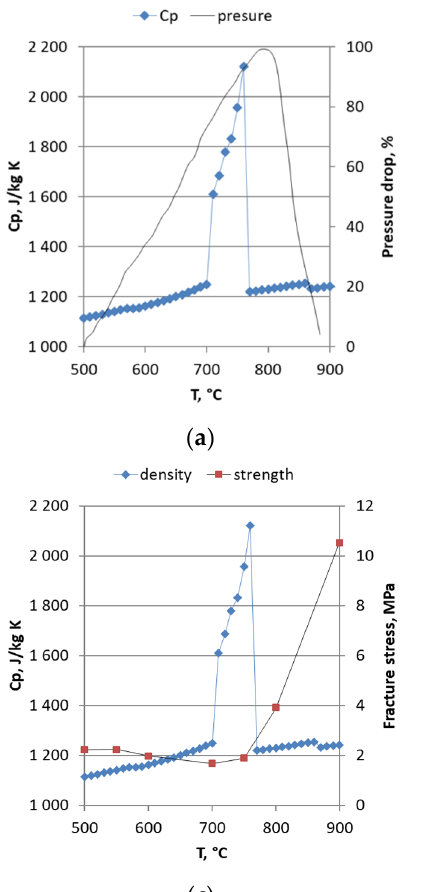
Figure 8. Barley straw: ( a ) Specific heat (c p ) and pressure drop as a function of temperature; ( b ) density (  )and pressure drop as a function of temperature; ( c ) specific heat and fracture stress as a function of temperature; ( d ) density and fracture stress as a function of temperature.